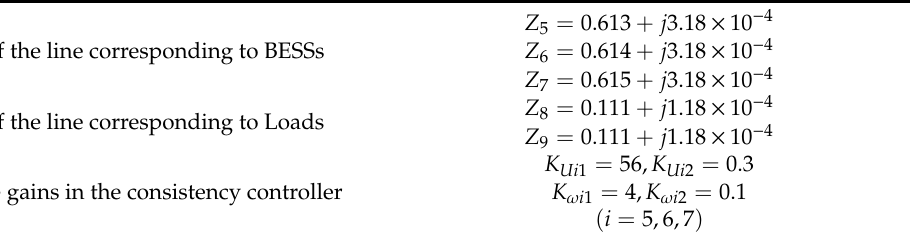
Figure 9. The related communication topology of the MG. Table 5. The related parameters of the BESSs loads.